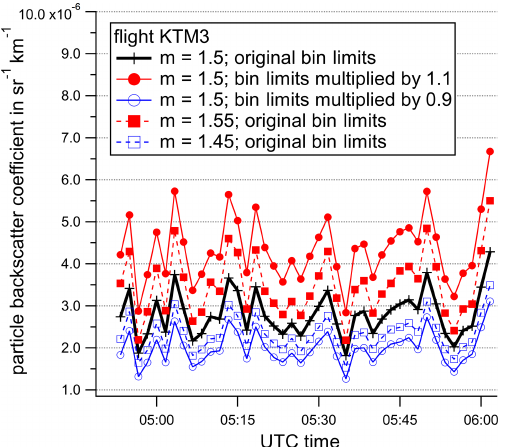
Figure B1. Sensitivity test of the aerosol backscatter coefficient calculation for different refractive indices ( m = 1 . 45, m = 1 . 5, and m = 1 . 55) and shifts of the bin limits of the aerosol size distribution by ± 10%.